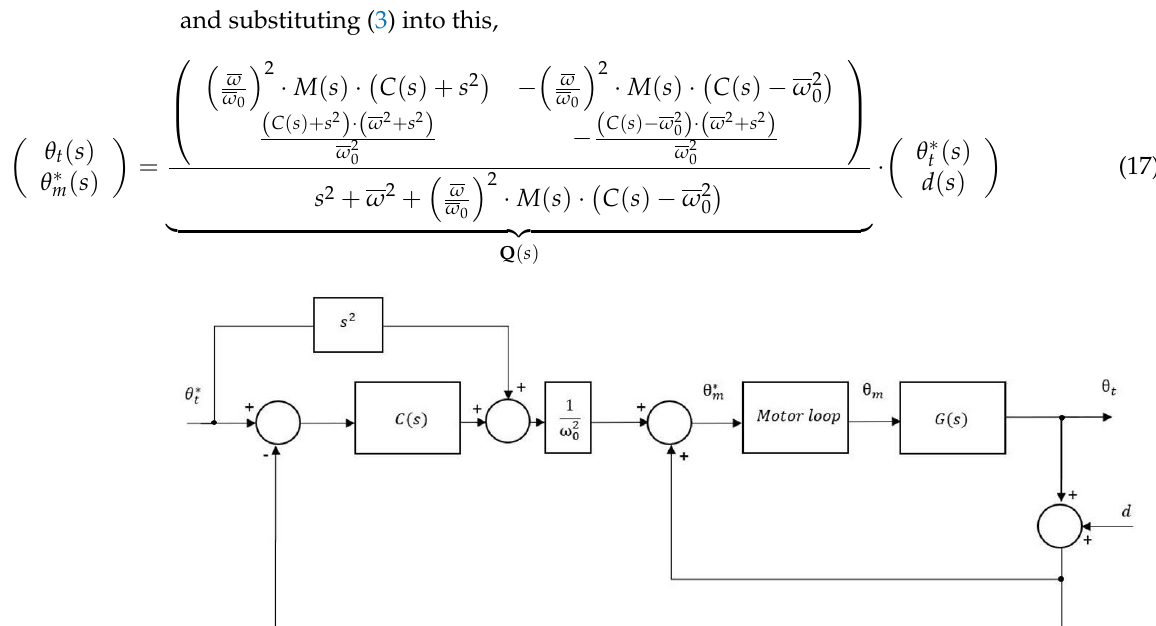
Figure 3. Outer control loop